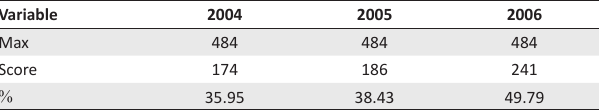
TABLE 3b: Analysis on corporate environmental disclosure in the mining sector based on later studies (case 2).